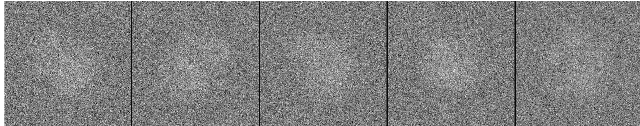
Figure 4. Simulated E. coli ribosome cryo-EM SPM particle images with SNR = 0 .